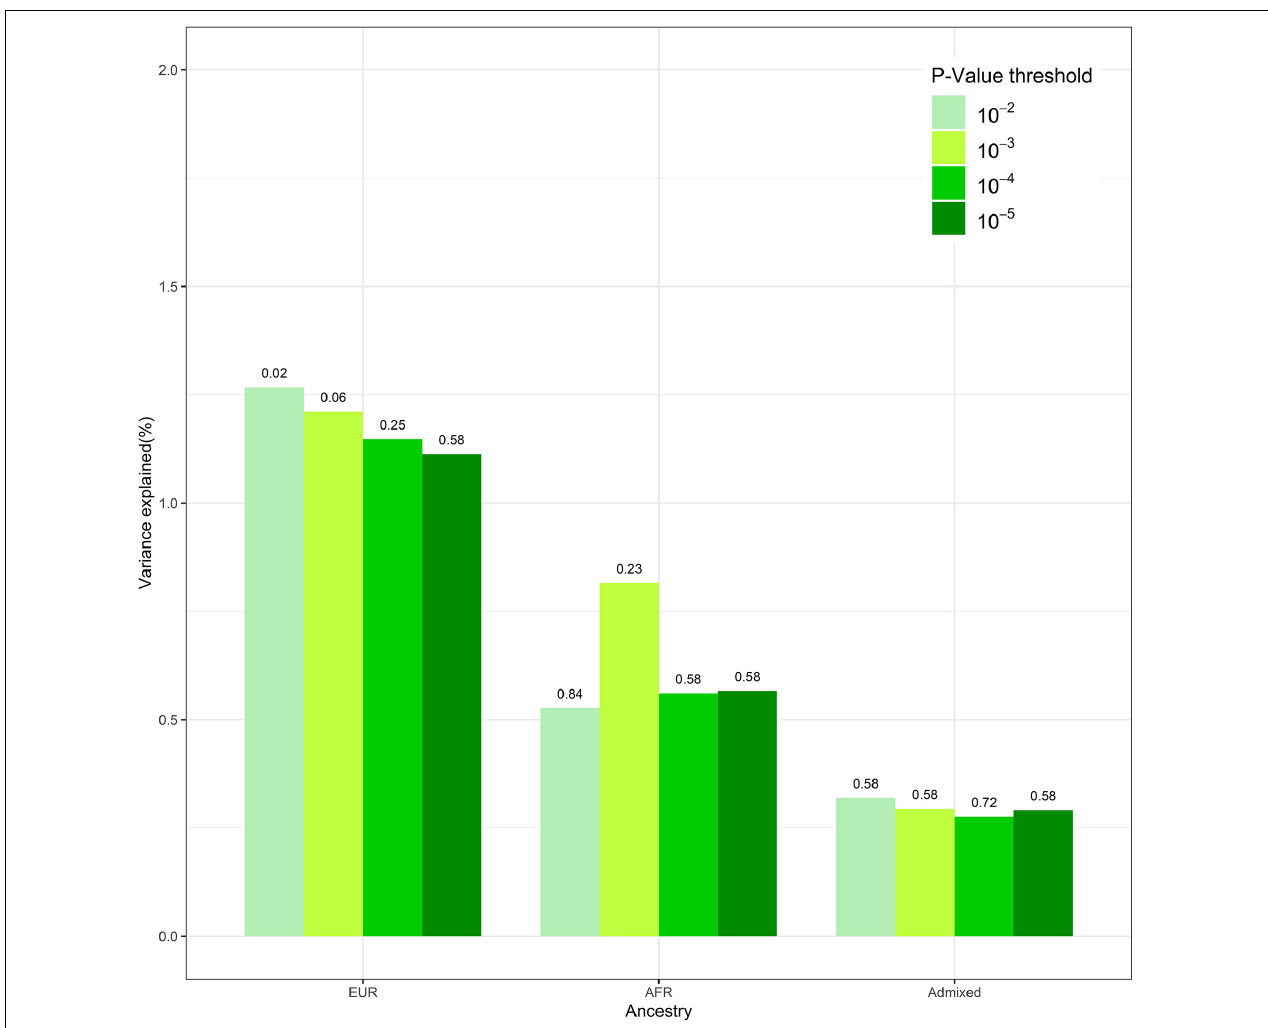
FIGURE 1 | The polygenic risk score (PRS) performance in disorders of initiating and maintaining sleep (DIMS) by different ancestries. This figure compared the performance of the models at different genome-wide association study (GWAS) p -value thresholds. The numbers above the bar represent the q -value for PRS at each